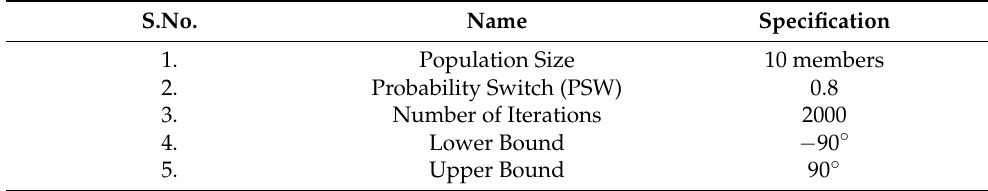
Table 1. Parameter Settings of